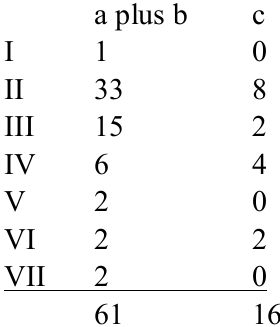
Tabulation B—Impact Model (assuming all “c” categories are impact)